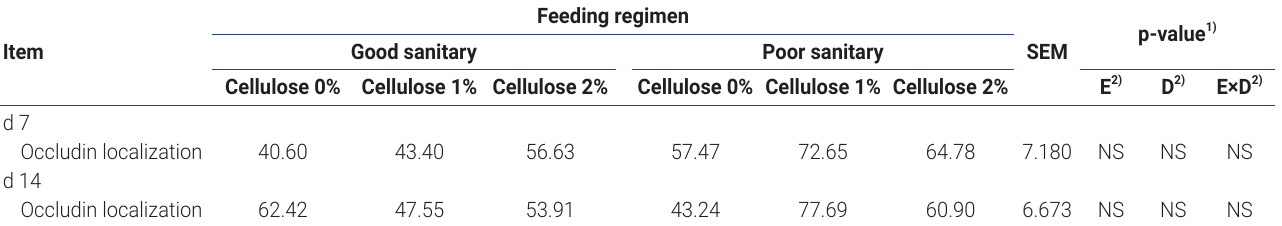
Table 5. Effects of environmental conditions and cellulose levels on occludin localization in weaned pig